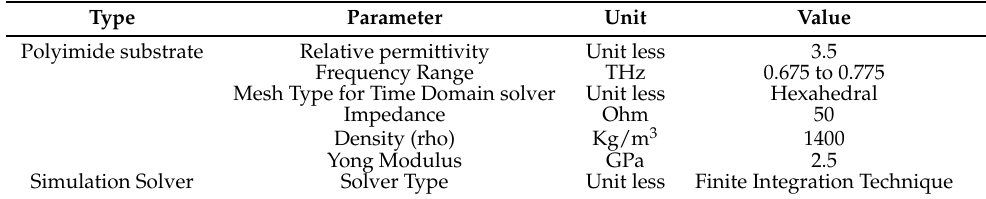
Table 3. Investigation of presented antenna models by simulation